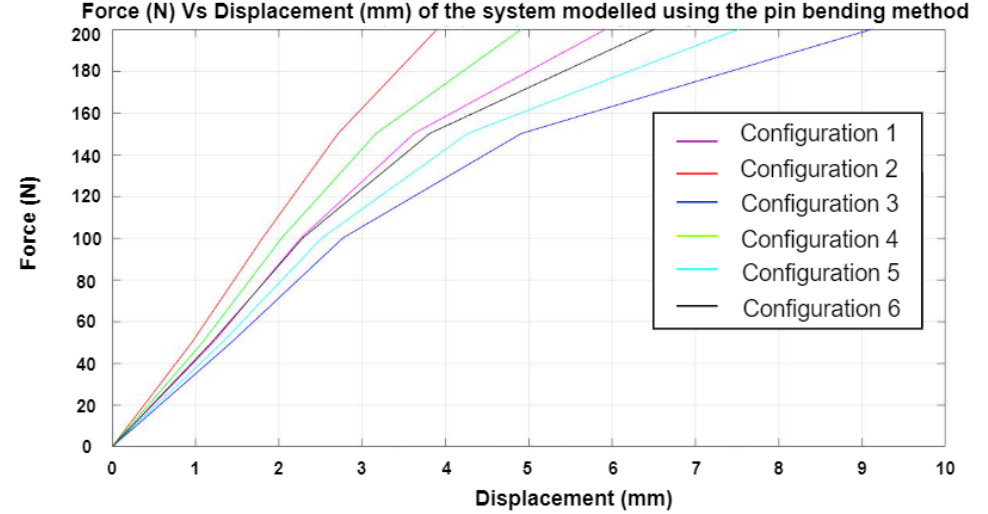
Figure 16. Simulated behavior of configurations, using pin bending model. Configuration 1—Magenta, Configuration 2—Red, Configuration 3—Blue, Configuration 4—Green, Configura- tion 5—Cyan, Configuration 6—Black.